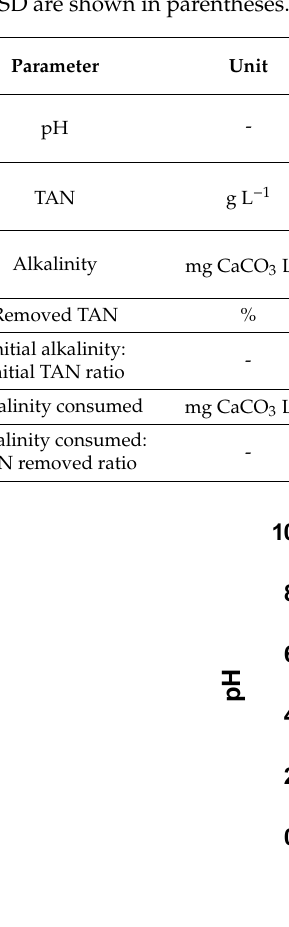
Table 3. Changes in chemical characteristics of raw swine manure during treatment in the pilot plant. SD are shown in parentheses.